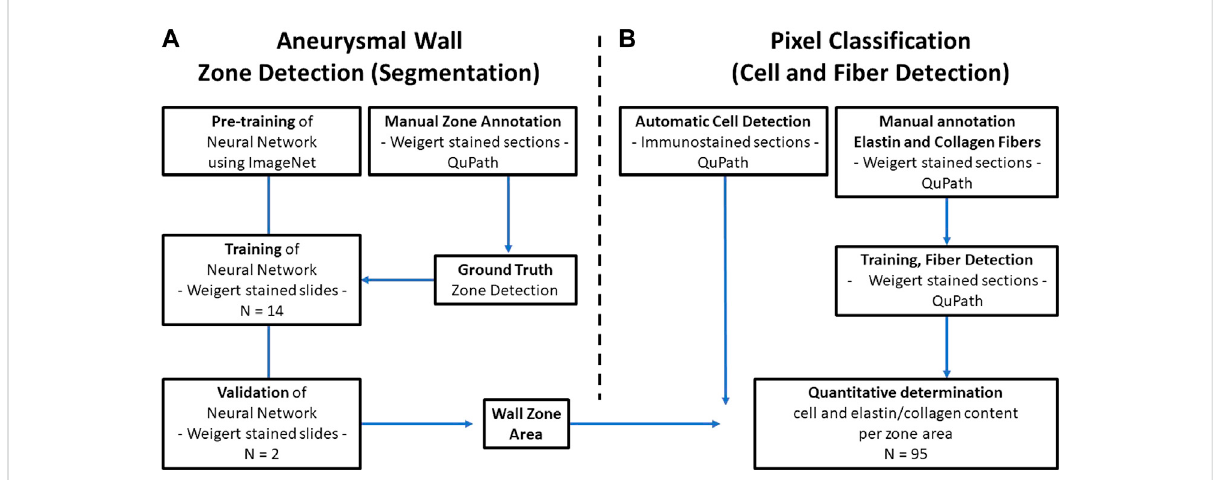
FIGURE 1 Data analysis fl owchart. (A) The Deep Neural network is pretrained on ImageNet and trained on basis of manually annotated images of Weigert stainedtissuesectionsofexcisedAAAspecimensfrom14patients.Themanualannotationde fi nesthegroundtruthforthenetwork.Theabilityofthe network to recognize the different de fi ned zones of the AAA wall is validated against manually annotated images from two other patients (B) In parallel, QuPath is used for detection of cells and elastin and collagen fi bers (right). Finally, by overlaying the de fi ned AAA wall zones and the QuPath output, quanti fi cation of the content of speci fi c cells and extracellular matrix fi bers per zone is possible.